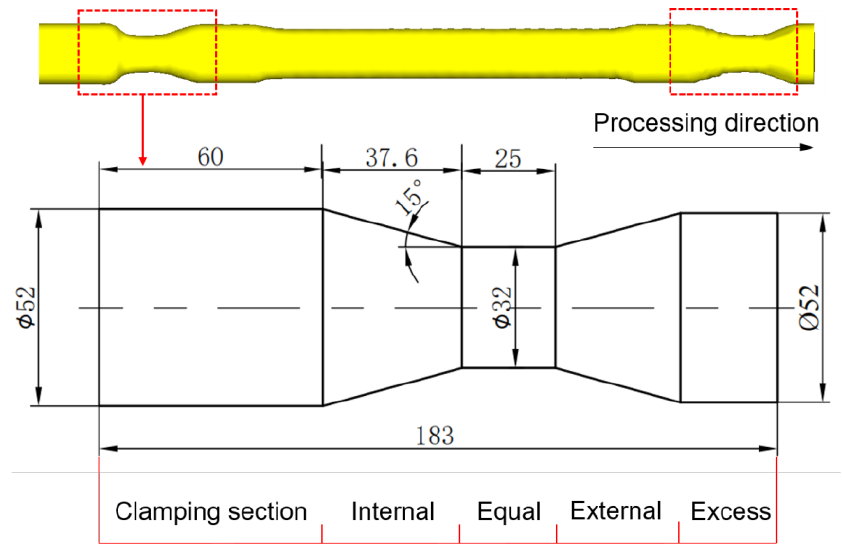
Figure 4. Simplified model of variable-diameter section.